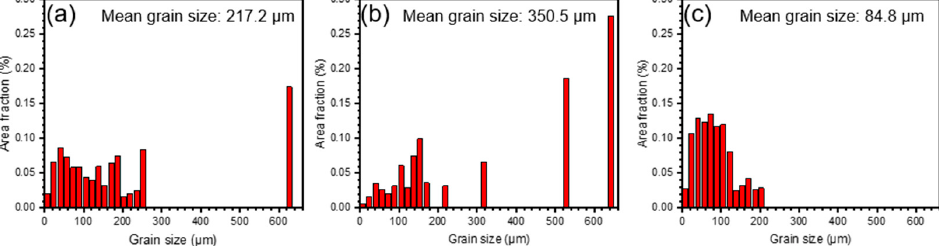
Figure 5. Grain size distributions in the vertical cross-section of EBM-In718 specimens: ( a ) 0 ° sample; ( b ) 55 ° sample and ( c ) 90 ° sample.